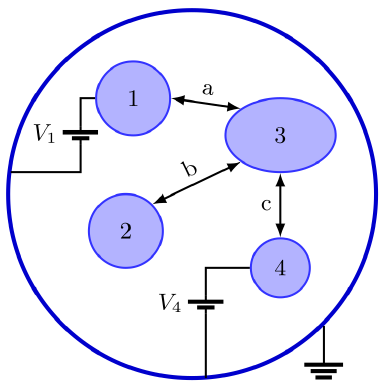
FIG. 1. A system of conductors. Two of them (1 and 4) are maintained at fixed potentials V 1 and V 4 by voltage sources. Elementary charges q are interchanged between them by devices e a , b , and c